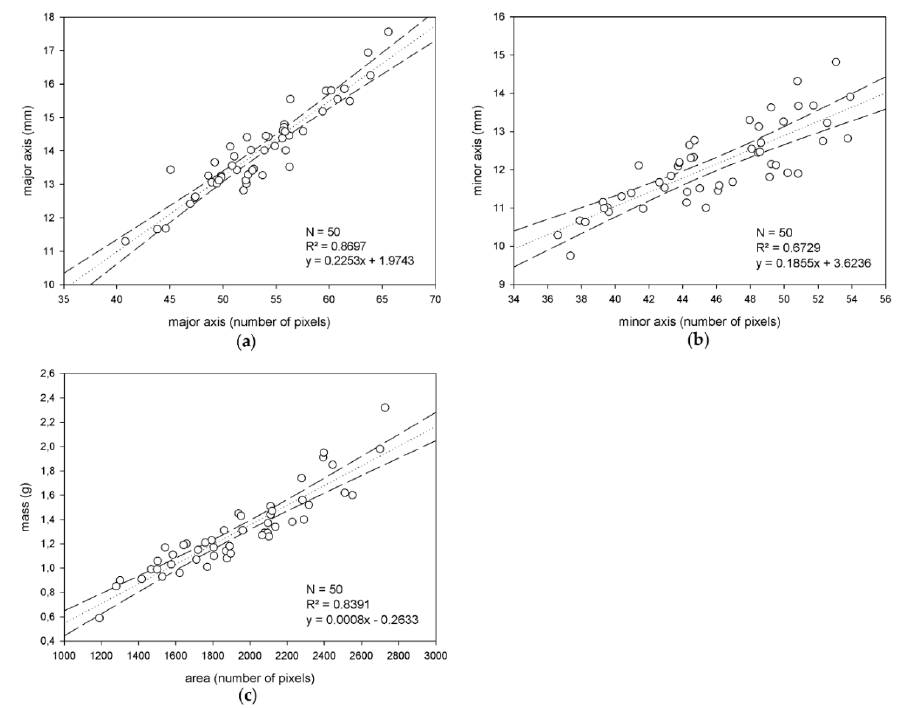
Figure 5. Correlation study performed for the Arbequina variety, considering the three different sizing features of the fruits the experiment is focused on: The major axis ( a ), minor axis ( b ) and mass ( c ).